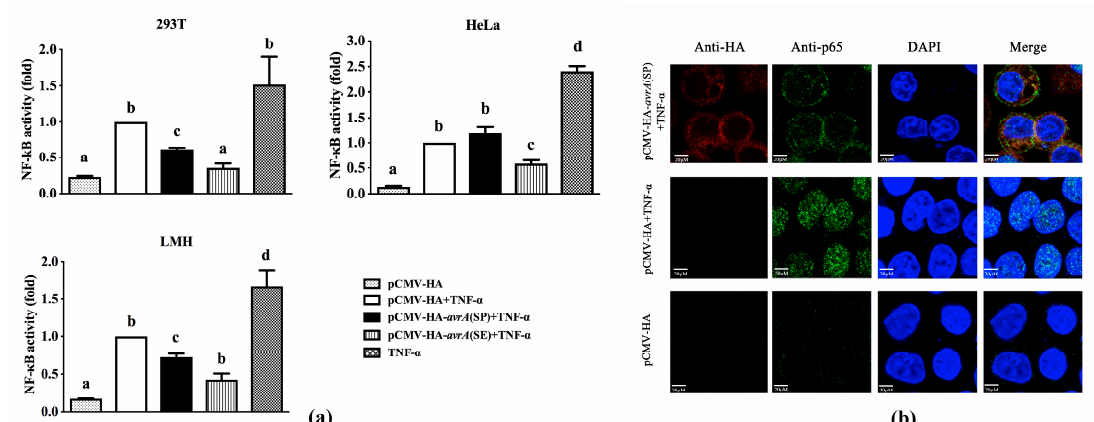
Figure 1. Transient expression of SP-AvrA inhibits the TNF- α activation of NF- κ B in transfected cells. ( a ) Dual NF- κ B reporter gene assays were performed in HeLa, 293T, and LMH cells cotransfected with plasmids pGL4.32, pRL-TK, and pCMV-HA or expression plasmid for SP-AvrA or SE-AvrA and stimulated with TNF- α (15 ng/mL) for 5 h. Data are expressed as the mean + SD and are shown as fold changes of renilla luciferase activity in cells transfected with pCMV-HA and induced by TNF- α (set as 1). The different letters on the on the error bars indicate statistically significant differences ( p < 0.05). ( b ) Confocal microscopy of p65 (green), HA-SP-AvrA (red), and nucleus of HeLa cell (blue) was performed in HeLa cells transfected with pCMV-HA- avrA (SP) and stimulated with TNF- α (15 ng/mL) for 30 min. The cells transfected with pCMV-HA were used as a positive control for p65 nuclear translocation. Expression of SP-AvrA in transfected HeLa cells inhibits translocation of p65 from the cytoplasm into the nucleus.